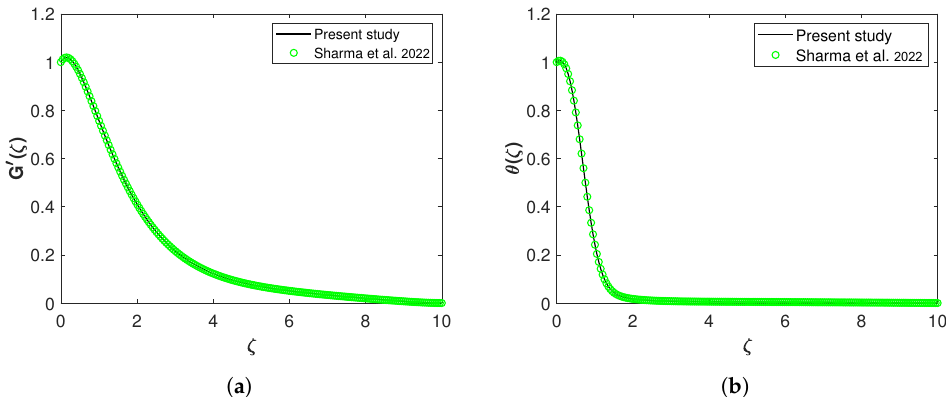
Figure 3. Comparative analysis of ( a ) velocity profile G (cid:48) ( ζ ) for Gc =1 and ( b ) temperature profile θ ( ζ ) for Pr = 7. Sharma et al.